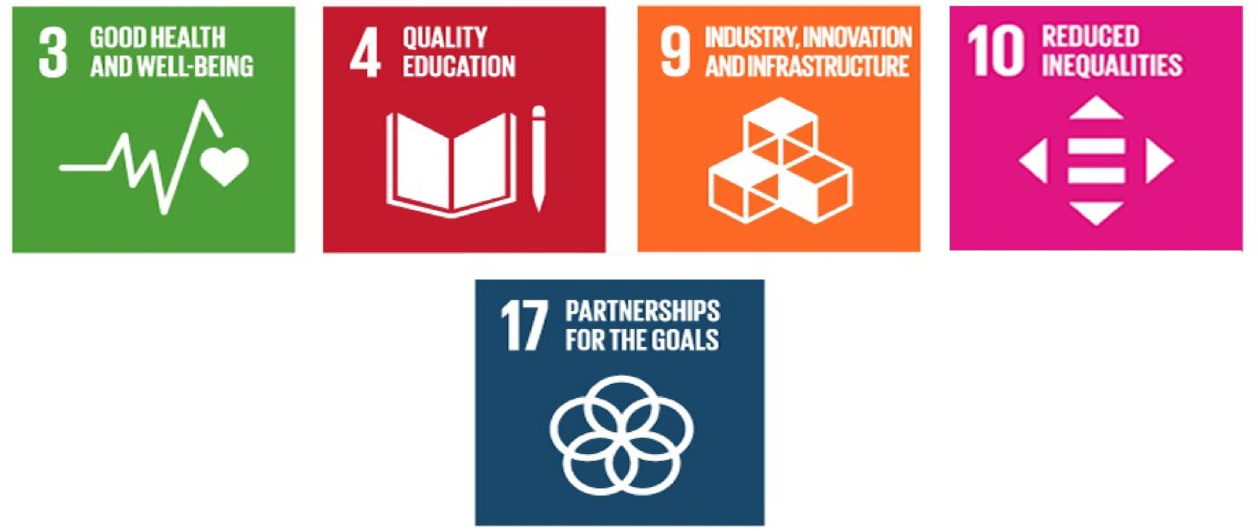
Fig 1. United Nations Strategic Development Goals, which can be impacted by Drug